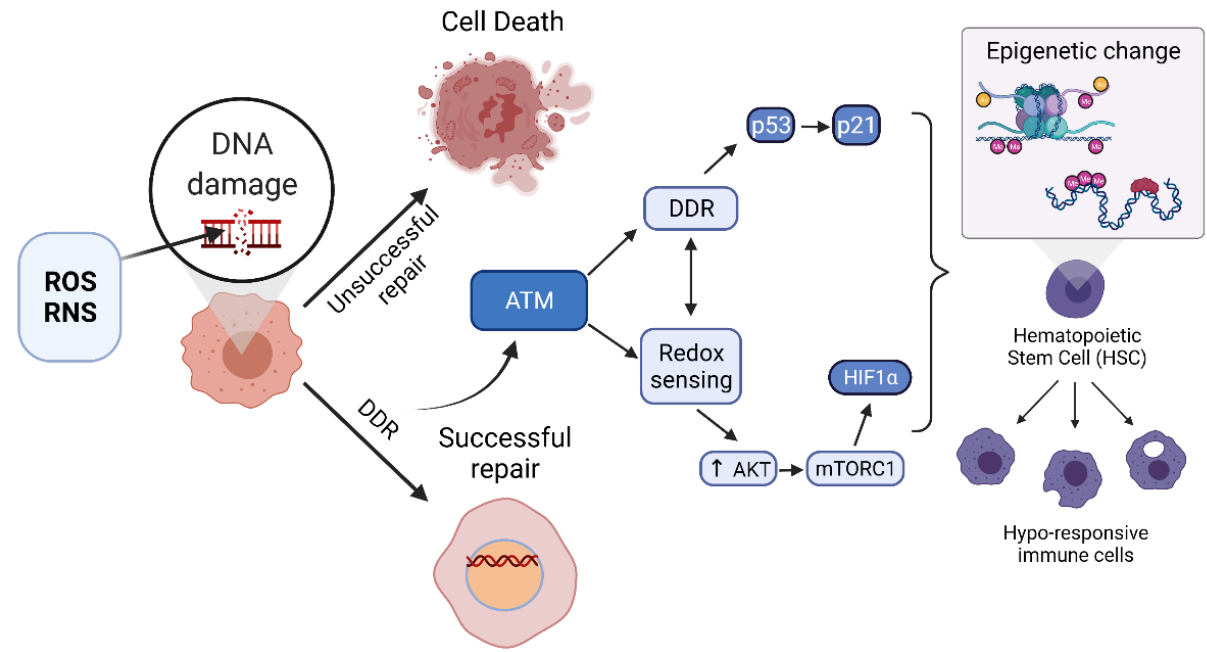
Figure 3. Successful upregulation of the DNA damage response (DDR) including high-fidelity repair responses activate ATM, which can activate additional DDR factors and can separately become activated by direct oxidation in a redox sensing manner. Activation of ATM leads to upregulation of transcription factors and epigenetic processes in somatic as well as hematopoietic stem cells (HSCs) that lead to suppression of pro-inflammatory programs in progeny innate immune cells.